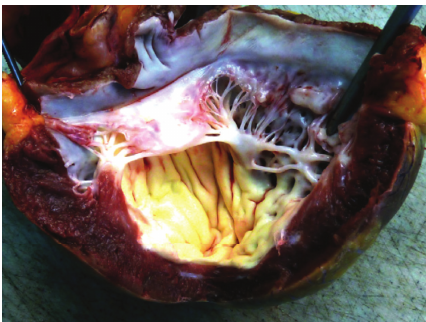
Figure 4: Pathologic specimen of the explanted heart. Endocardial fibroelastosis of the left ventricle affecting the papillary muscles with thickened and shortened chordae tendineae and the aortic and mitral valve (reprinted from [1] with permission from